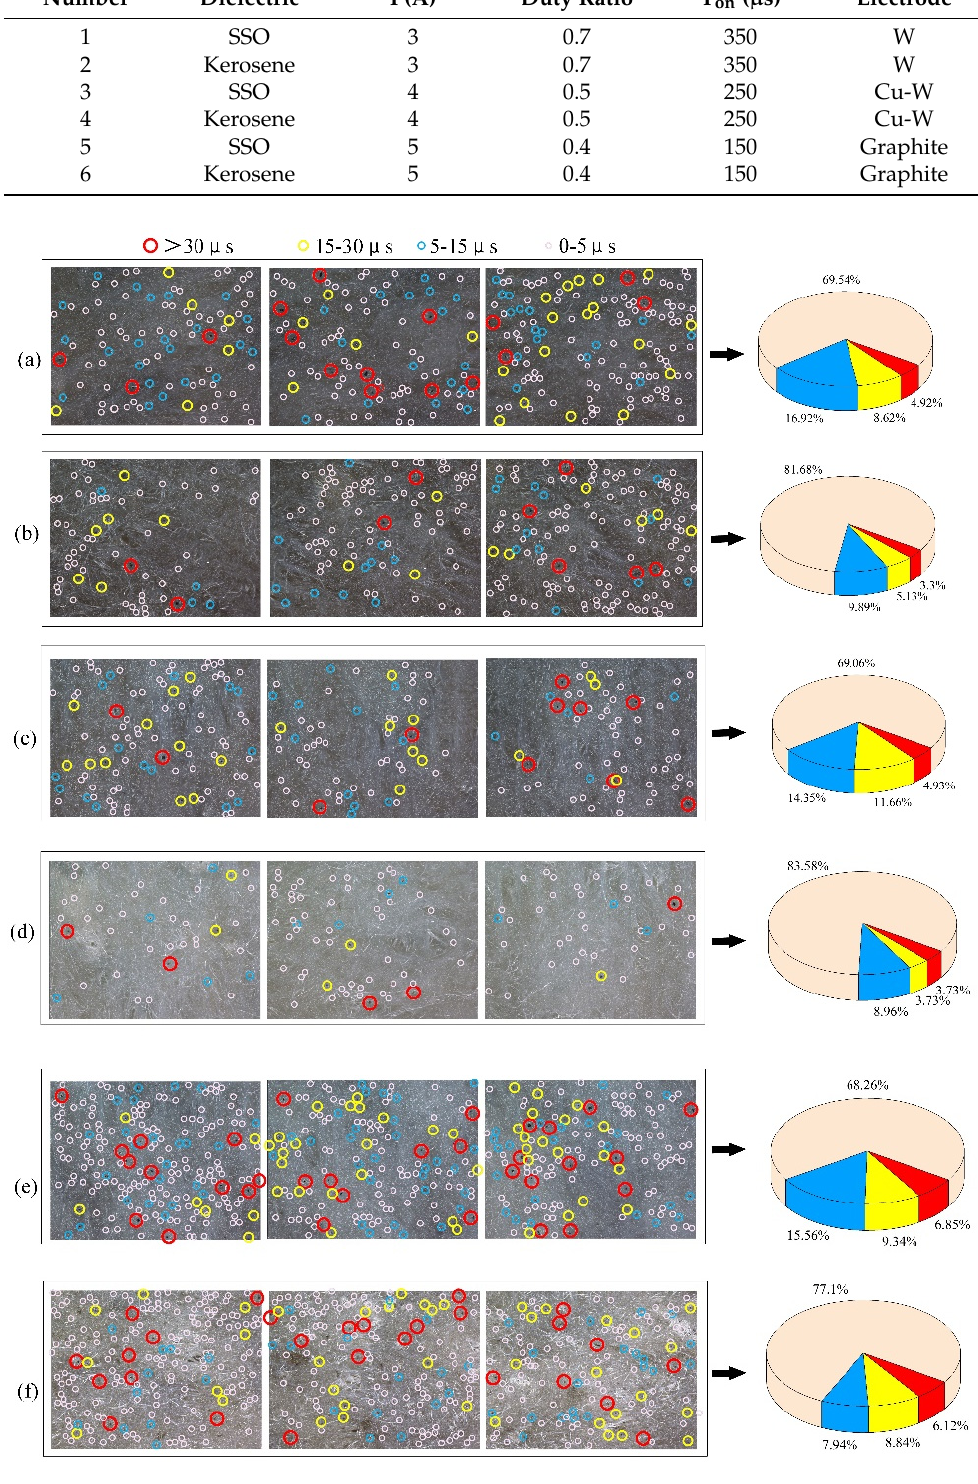
Figure 8. Debris distribution on different process parameters; ( a ) SSO, 3A, 0.7, 350 µ s, W; ( b ) kerosene, 3A, 0.7, 350 µ s, W; ( c ) SSO, 4A, 0.5, 250 µ s, Cu-W; ( d ) kerosene, 4A, 0.5, 250 µ s, Cu-W; ( e ) SSO, 5A, 0.4, 150 µ s, Graphite; ( f ) kerosene, 5A, 0.4, 150 µ s,